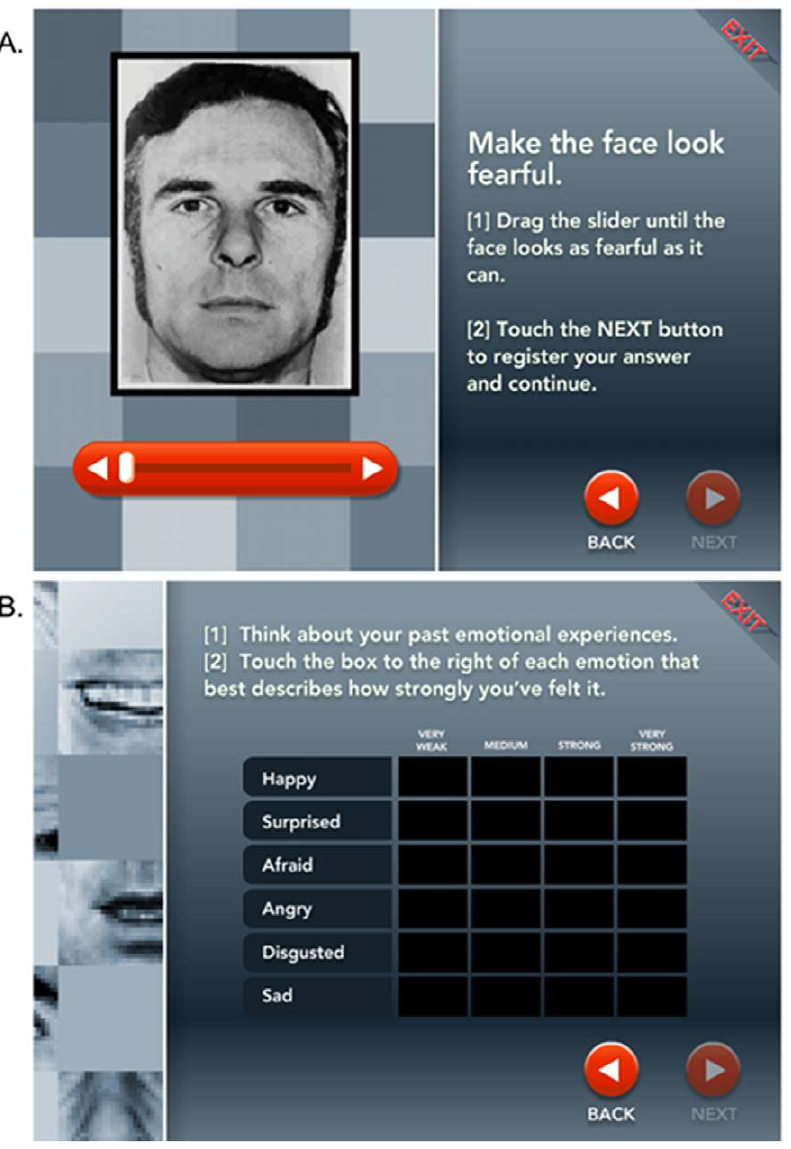
Figure 1. Stimuli Used in the Study. Example screenshots of A) the facial affect recognition task and B) the emotional experience task.